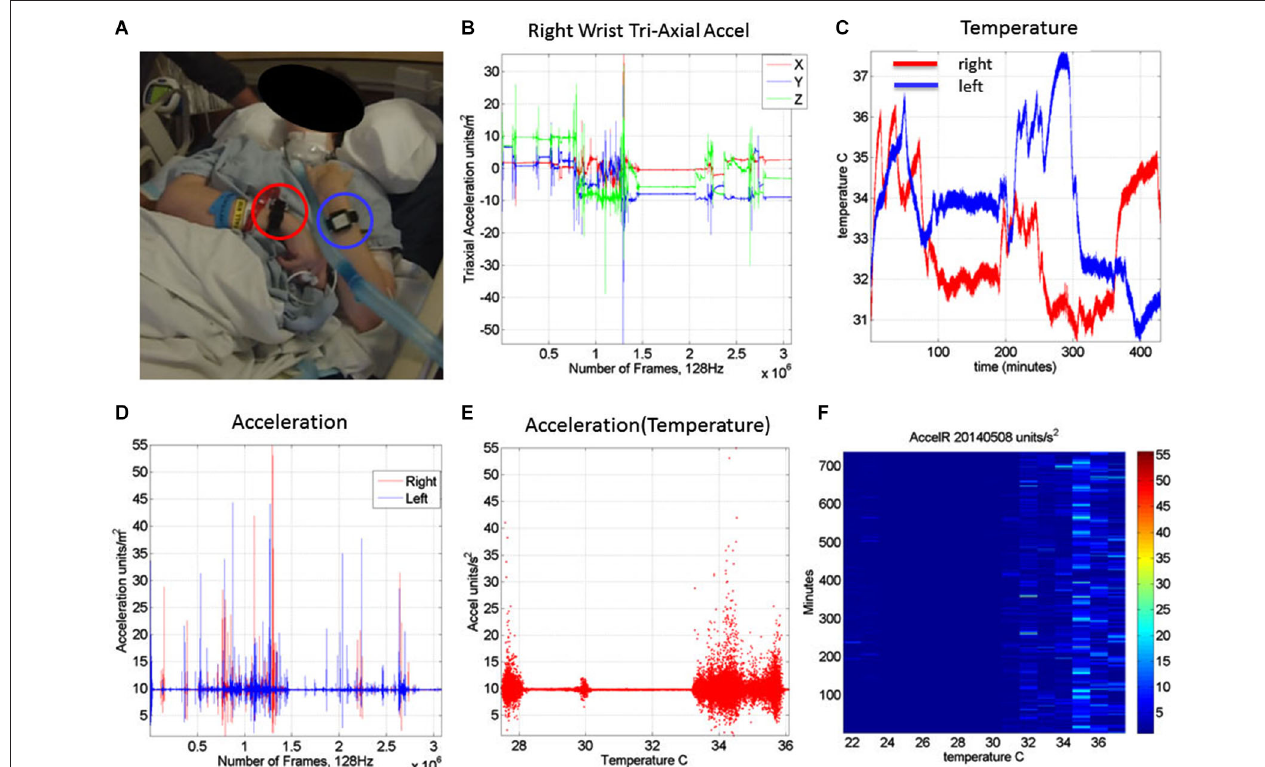
temperatures registered across the 7.09 h session of April 24th 2014. (F) Matrix of maximal deviations from the mean acceleration values registered on May 8th 2014 for the temperature range and time duration in minutes (for 12.28 h). For each minute and ◦ C the motion content was registered. The color bar shows the range of the motion values (units/s 2 ). The range of changes in temperature values was registered between 22 ◦ C and 38 ◦ C for that day’s recording